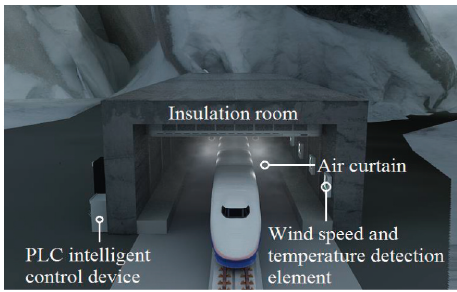
Figure 2: Structure of the tunnel air curtain insulation system on the dark side of the mountain.